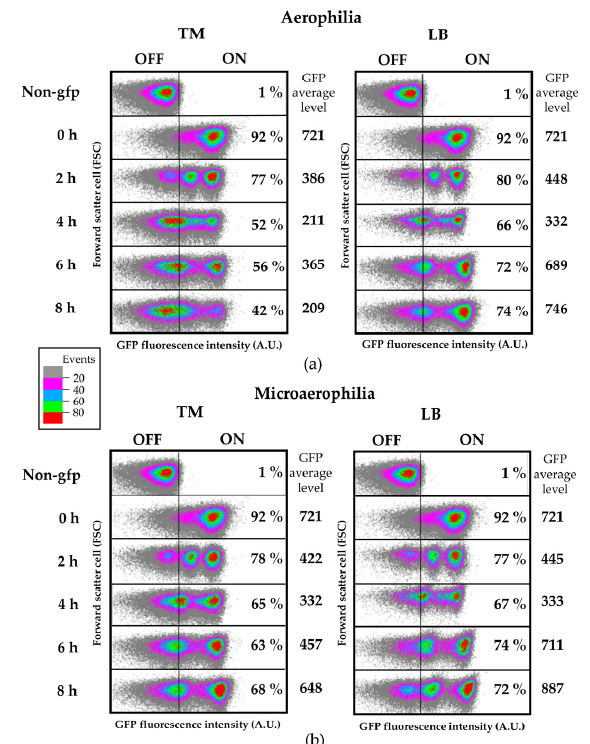
Figure 5. The fliC gene is heterogeneously expressed in plant-supplemented media. Dot plots showing time course expression of fliC::gfp in tomato-based (TM) and LB media under aerophillic ( a ) and microaerophillic ( b ) conditions. Dot plots represent the GFP fluorescence intensity versus the forward scatter cell or the cell size, both in arbitrary units (A.U.) The OFF subpopulation is defined as the fluorescence level below which 99% of the cells of a non-gfp control strain cultured in the same conditions. Percentages of ON cells are indicated inside the graphs. The average level of GFP intensity for each time and condition is shown to the right of the dot